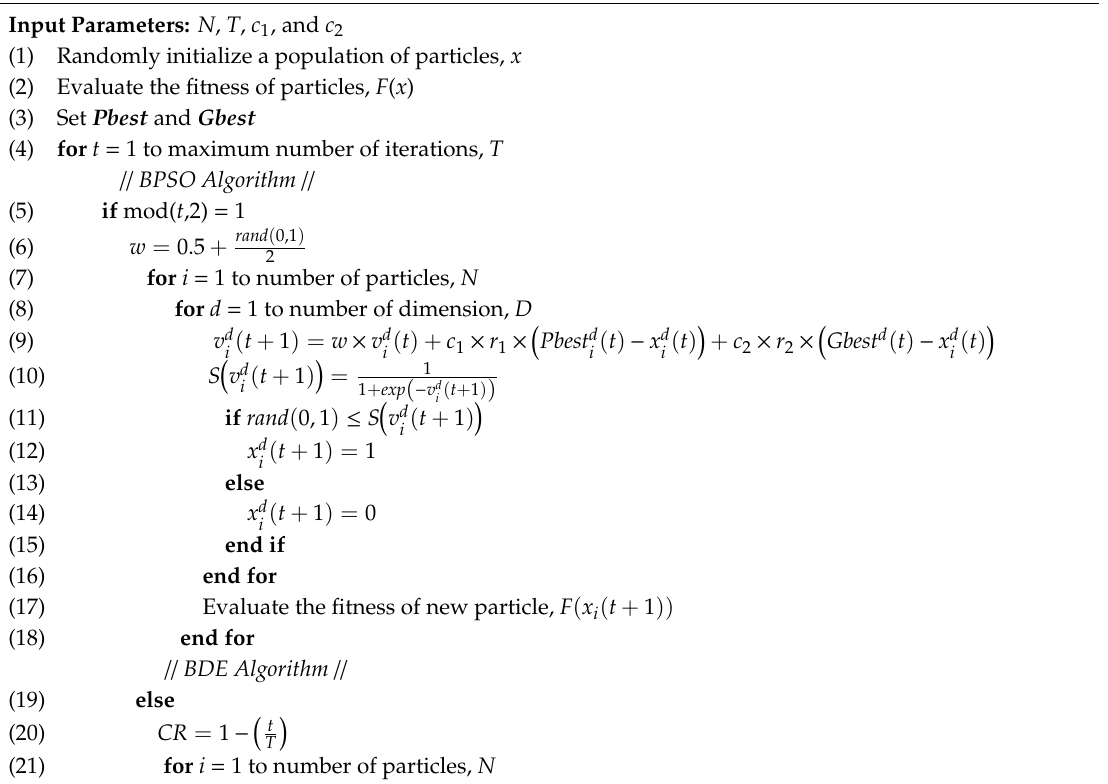
Algorithm 1. Hybrid Binary Particle Swarm Optimization Di ff erential